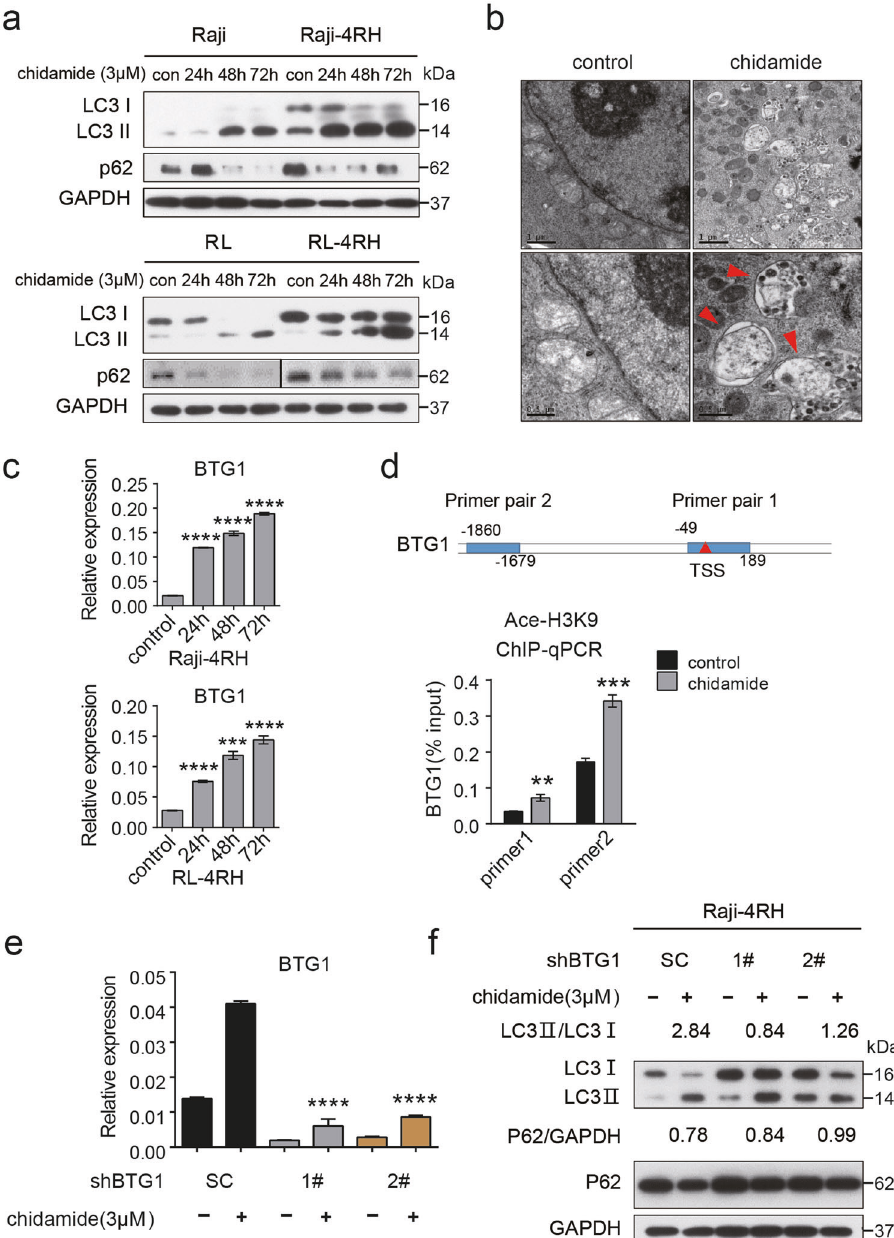
Fig. 6 Chidamide treatment induced robust autophagy through upregulation of BTG1. a RSCL and RRCL were treated with DMSO or chidamide (3 μ M) for 24, 48, or 72 h and autophagy-related proteins were detected by using Western blot analysis ( N = 3). b More autophagosomes of Raji-4RH were detected in Raji-4RH treated with chidamide (3 μ M) compared with the DMSO control, red arrows indicates autophagosomes observed in electron microscope ( N = 1). c Expression of BTG1 in Raji-4RH and RL-4RH treated with chidamide (3 μ M) for 24, 48, or 72 h were detected by Q-PCR ( N = 3). d Raji-4RH was treated with chidamide (3 μ M) or DMSO for 24 h and then cells were collected for ChIP assay. DNA fragments were pulled down with Ace-H3K9 antibody or negative IgG antibody. Enrichment of BTG1 promoter sequences were examined by Q-PCR and normalized to input chromatin DNA, and primers were designed as the sketch indicated ( N = 3). e Ef fi ciency of BTG1 knock down with shRNA before and after chidamide treatment were examined by using Q-PCR analysis ( N = 3). f ShRNA SC, shRNA#1 and #2 Raji-4RH were treated with chidamide (3 μ M) for 48 h, and then autophagy-related proteins LC3-II, LC3-I, and p62 were examined by using Western blot analysis ( N = 3). SC Scramble. For all graphs, data are presented as mean ± SD, * p < 0.05, ** p < 0.01, p < 0.005***, p < 0.001****. Statistical analysis was performed with a paired t